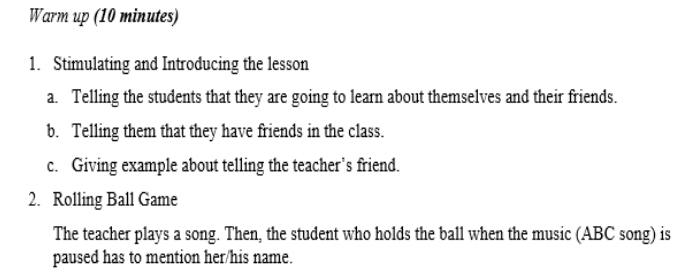
FIGURE 2 | Warm-Up Activity for Grade One – Rolling Ball Game